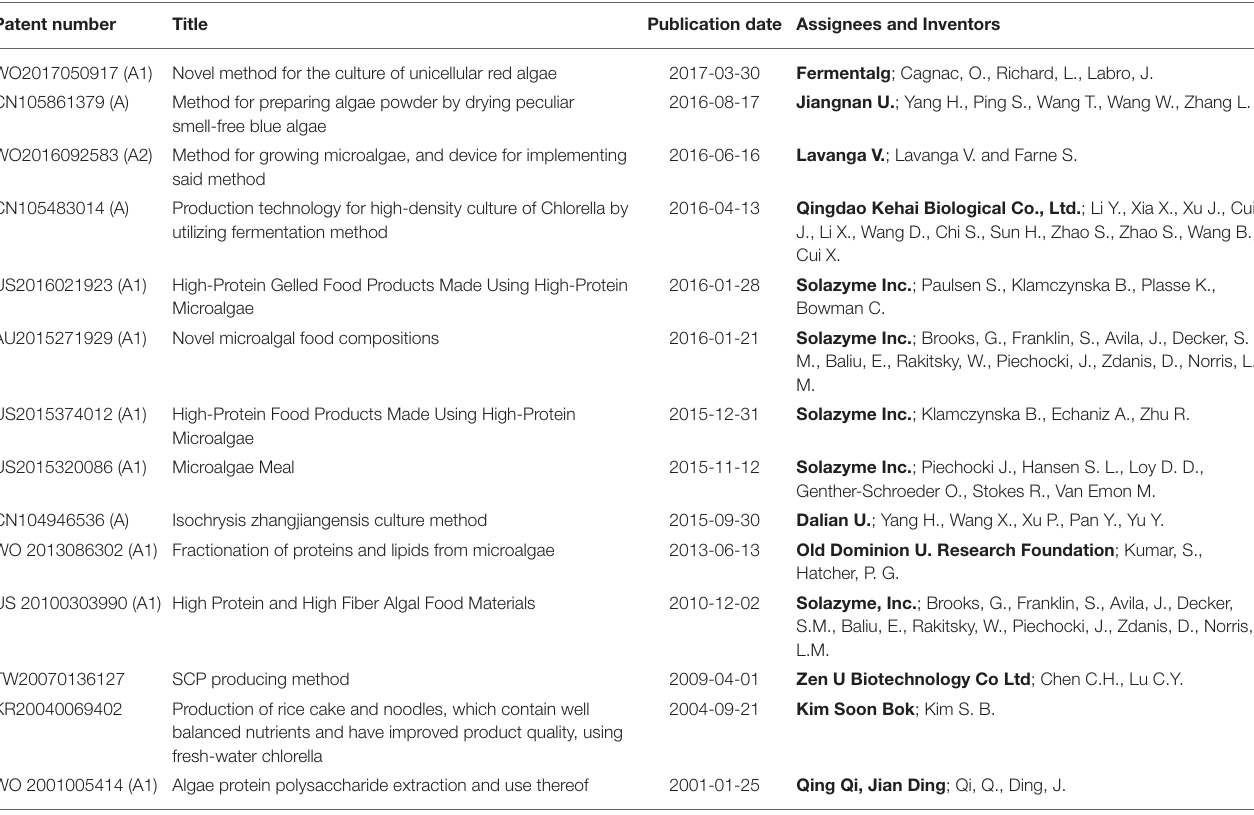
TABLE 5 | Patents related to the production of SCP from algae during